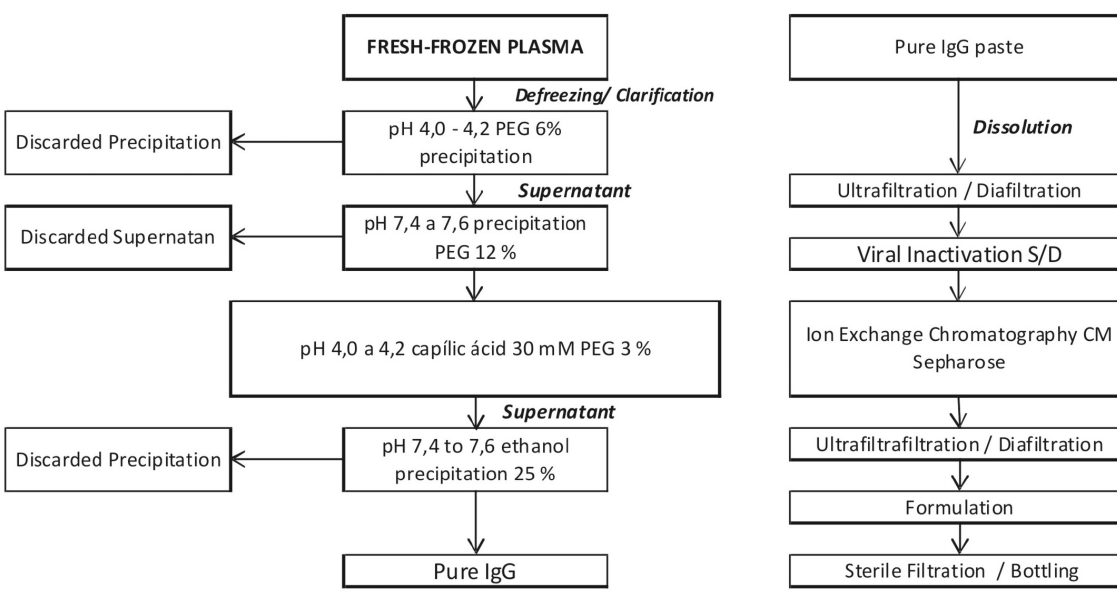
FIGURE 1 - Flow chart showing purification and production of IV IgG 5% used in the present